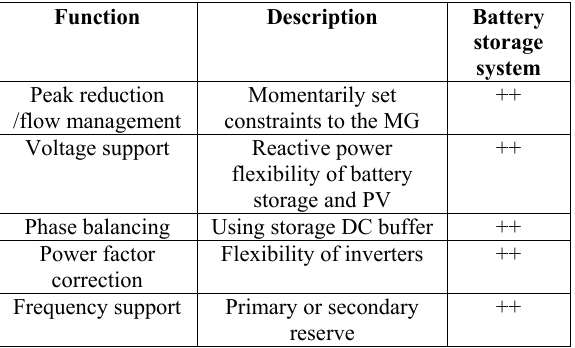
Table 2. Advantages for the public grid